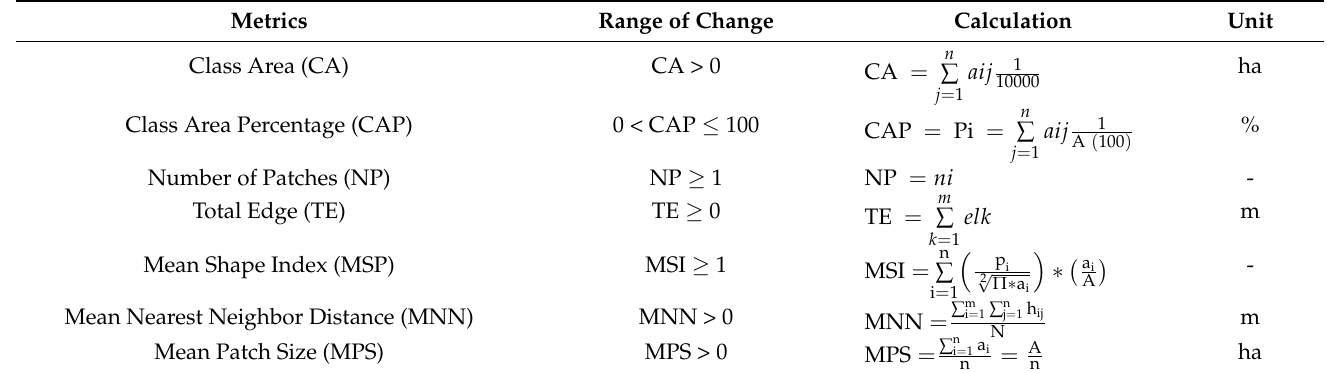
Table 1. List of landscape metrics used in the studied areas